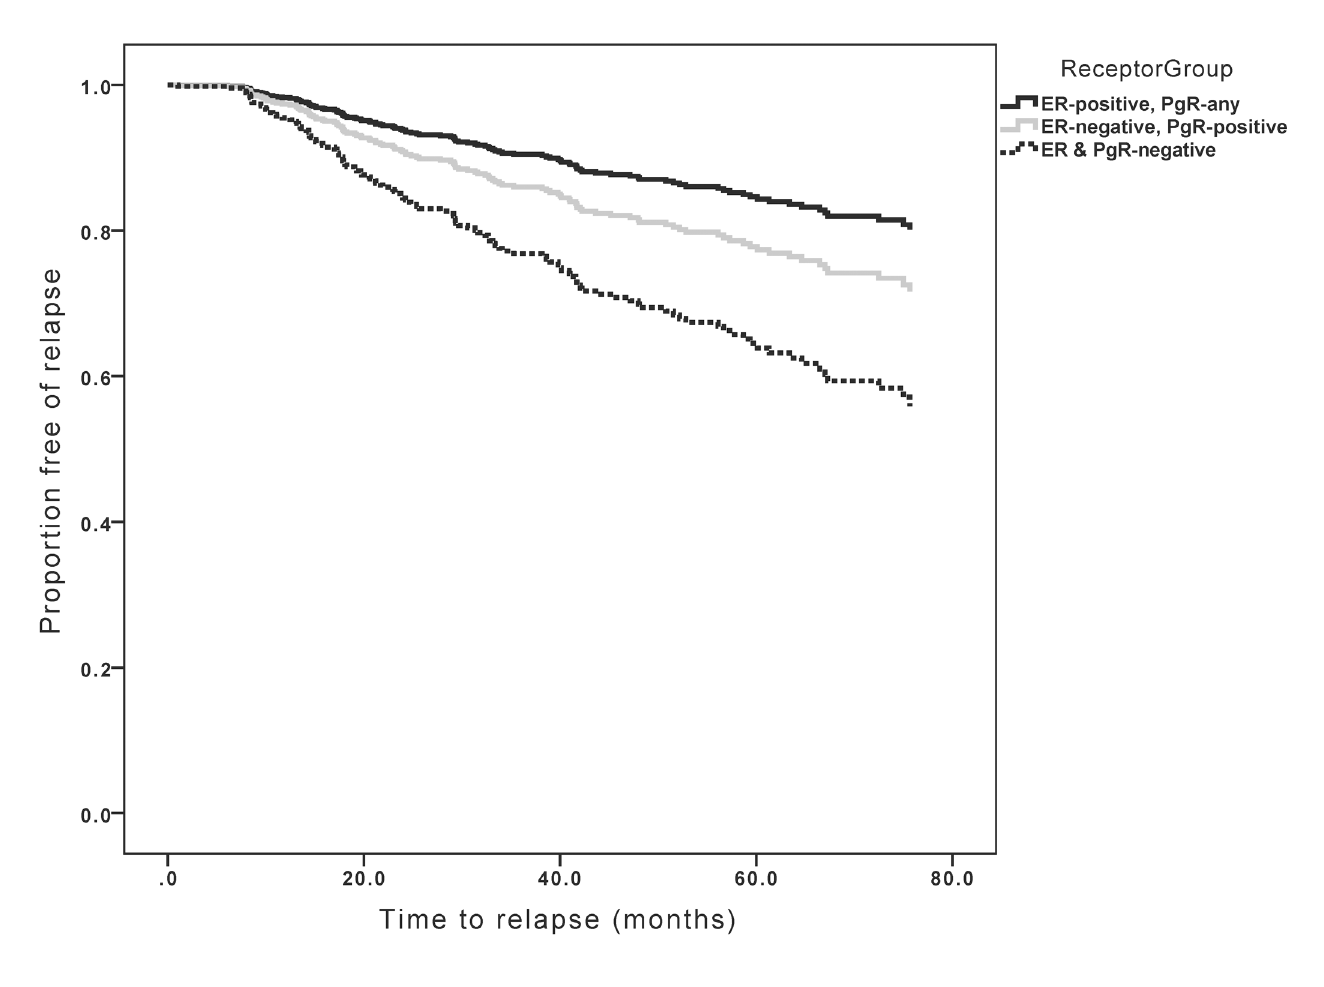
Fig 1. Kaplan-Meier curves for time to relapse based on receptor